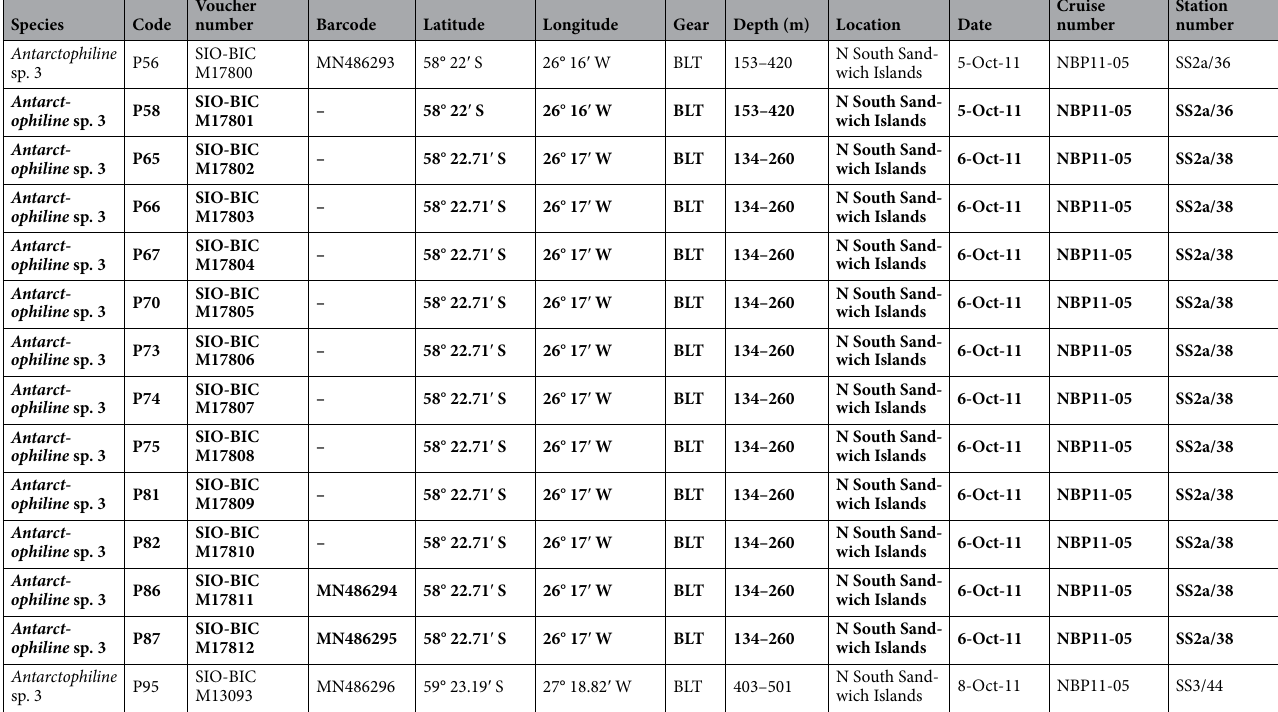
Table 1. Samples obtained from the SIO-BIC, MCZ, MNA, WAM, ZMBN (University Museum of Bergen), and ZSM, including voucher numbers, collecting site and date, geographical and bathymetric distribution,